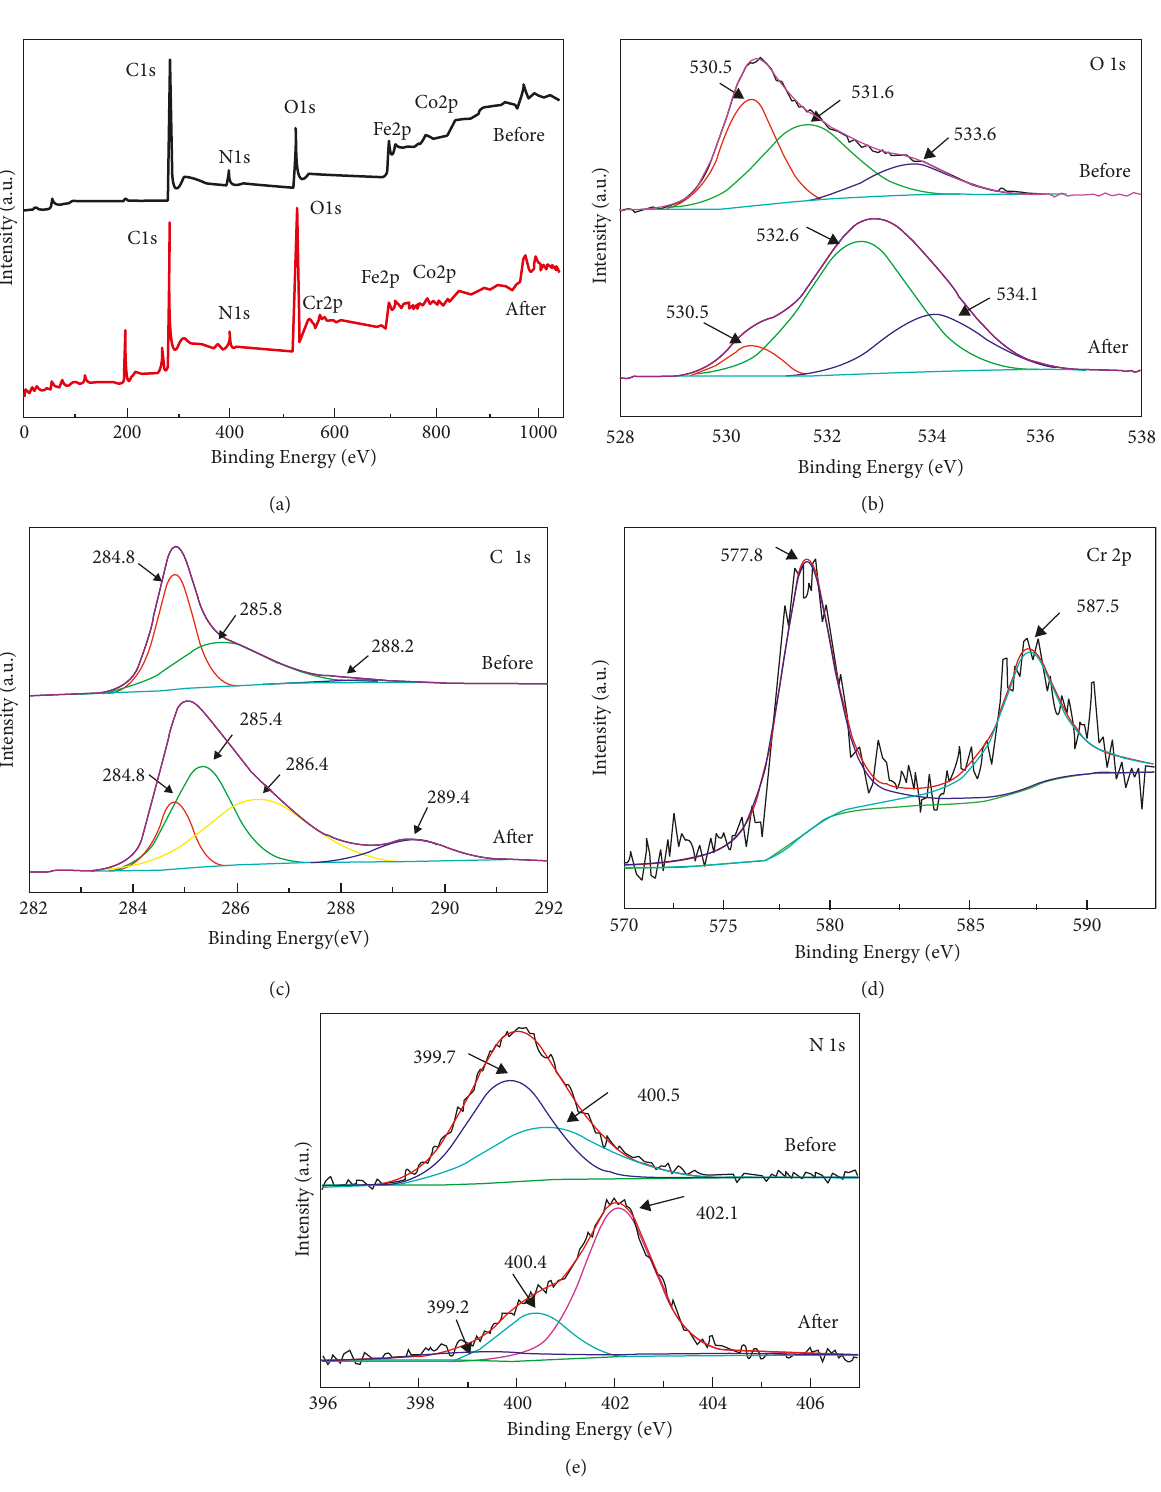
Figure 7: (a) XPS spectra of TGOM before and after adsorption of Cr (VI) and high-resolution XPS survey of (b) O 1 s, (c) C 1 s, (d) Cr 2p, and (e) N